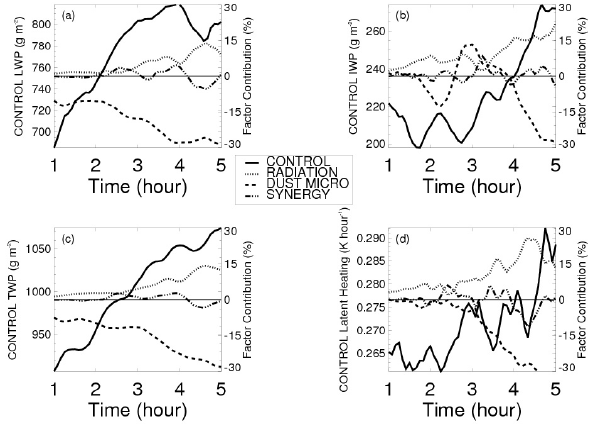
Fig. 6. Domain-averaged time series of (a) liquid water path (g m 2 ) , (b) ice water path (g m 2 ) , (c) total water path (g m 2 ) , and (d) tro- posphere depth normalized, vertically integrated latent heating rate (Kh − 1 ) . The solid lines correspond to CONTROL with the full field values on the left axes. The dotted (RADIATION), dashed (DUST MICRO), and dot-dashed (SYNERGY) lines correspond to the fac- tors and are expressed as a percent contribution to CONTROL – shown on the right